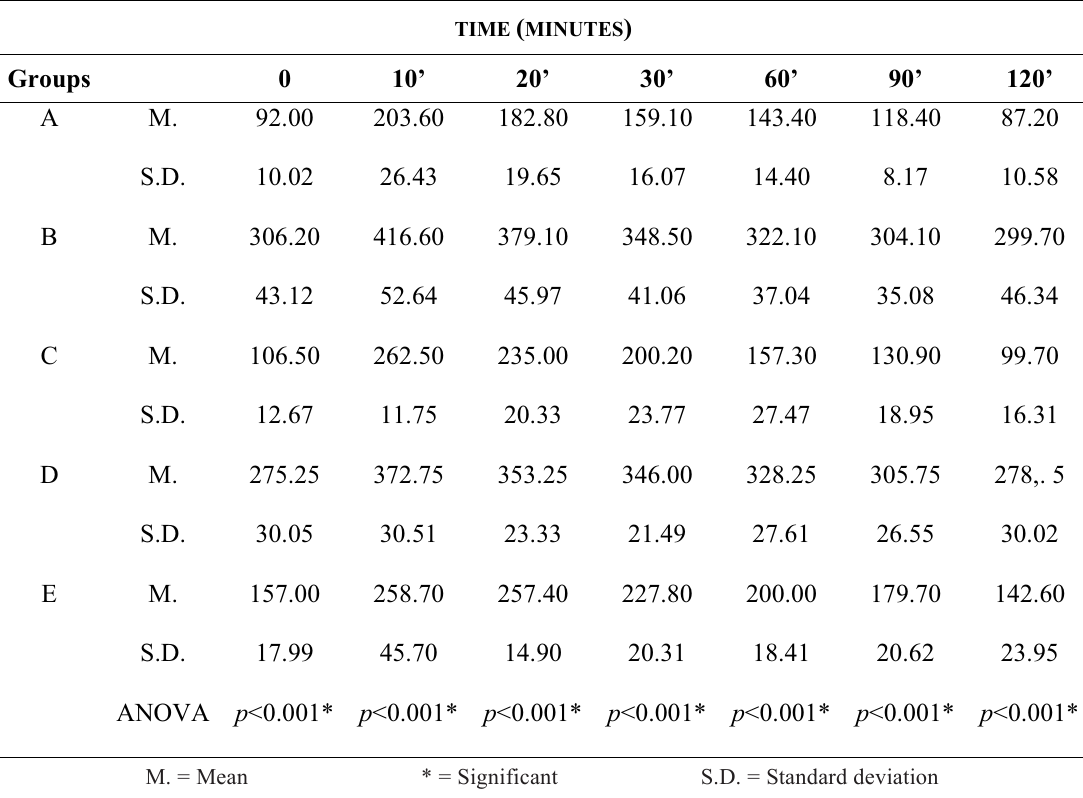
TABLE 2 - Mean values (mg%) and the respective standard deviations of the intravenous glucose tolerance test (IGTT), performed on the animals in groups A (control), B (apancreatic), C (autotransplant), D (allograft without immunosuppression) and E (allograft with